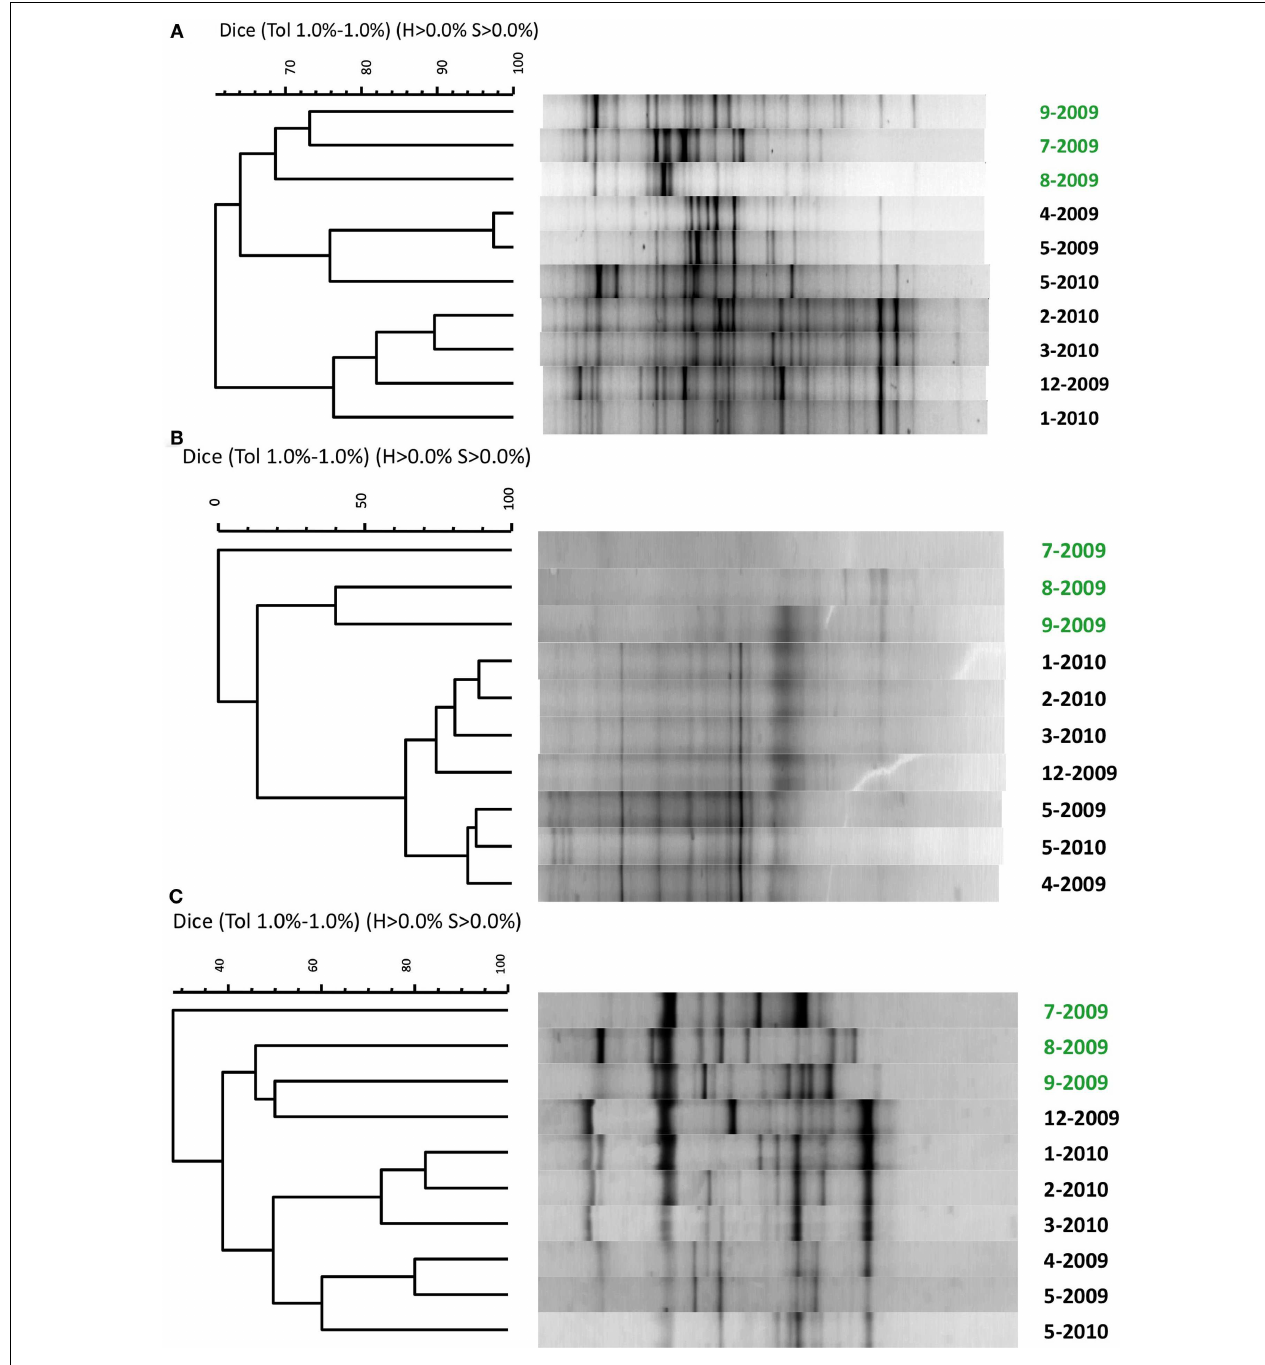
each replication (data not shown), only representative samples from site 3 from each month are shown.Water samples were collected from April 2009 to May 2010 with month (number) and year indicated on the right axis. Samples in green font indicate summer months with phytoplankton